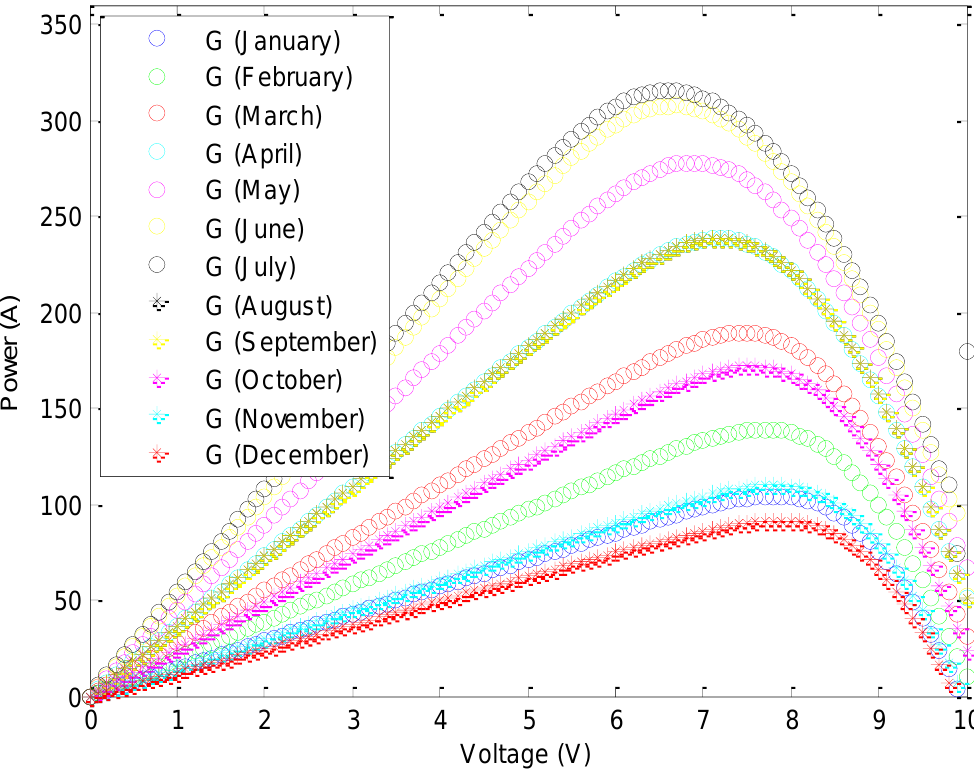
Figure 8. Power-voltage characteristic curves of photovoltaic cells for various irradiation and constant temperature in Shkoder,